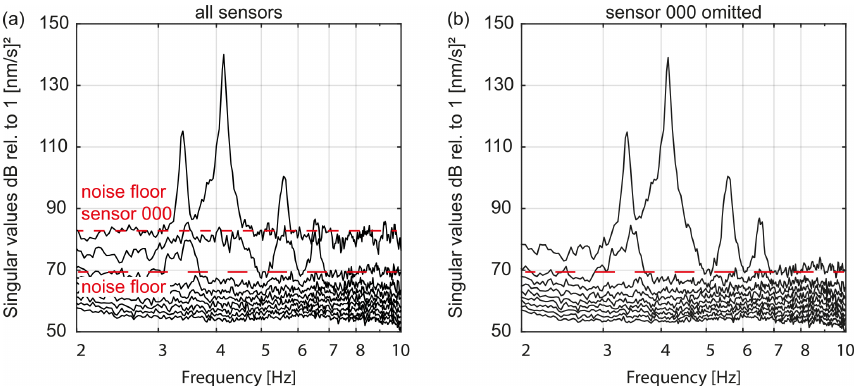
Figure 6. First nine singular values of the EFDD analysis of Musselman Arch. (a) Singular values including all 32 sensors. An anomalous horizontal component of sensor 000 increased the noise floor close to the peak of the fourth resonant frequency. However, the higher singular values still clearly point out the four resonant frequencies. (b) Singular values excluding sensor 000, resulting in a lower noise floor at 70dB and clear peaks on the first singular value at the resonant